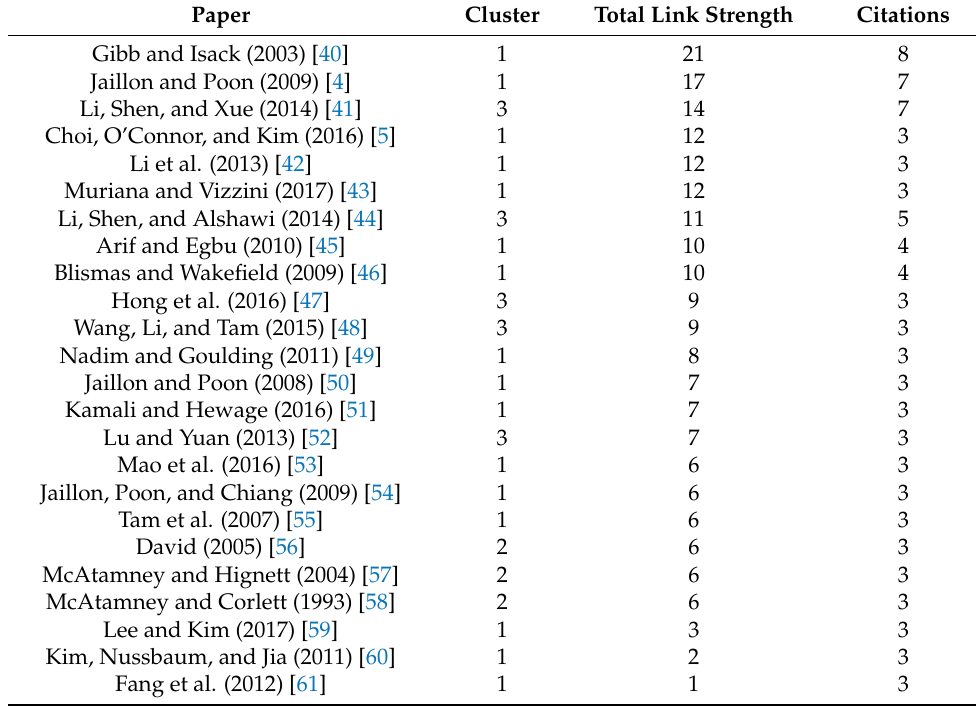
Table 3. Highly co-citation